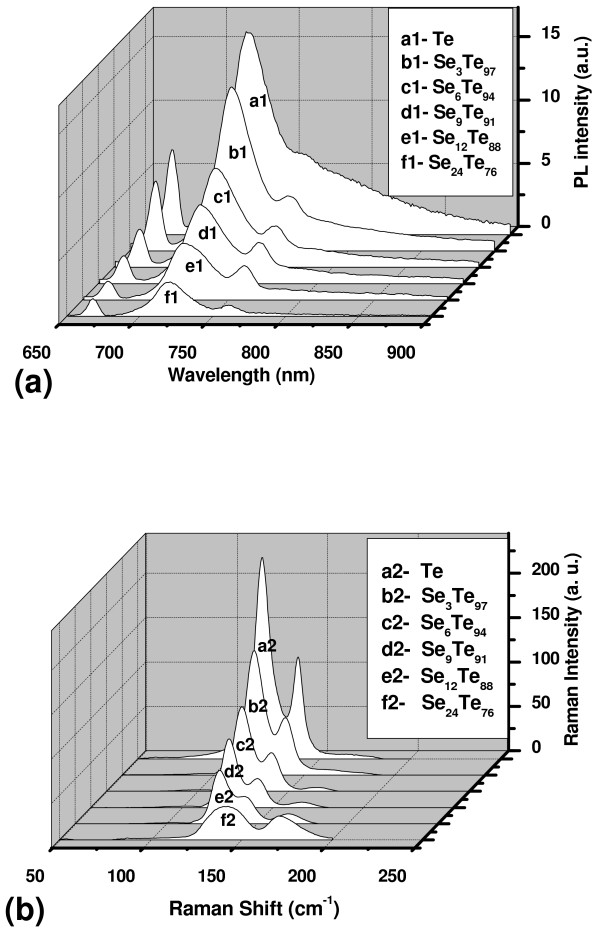
Photoluminescence emission spectra (a) and (b) Raman spectra. Of the thin films of SexTe100 − x nanoparticles.